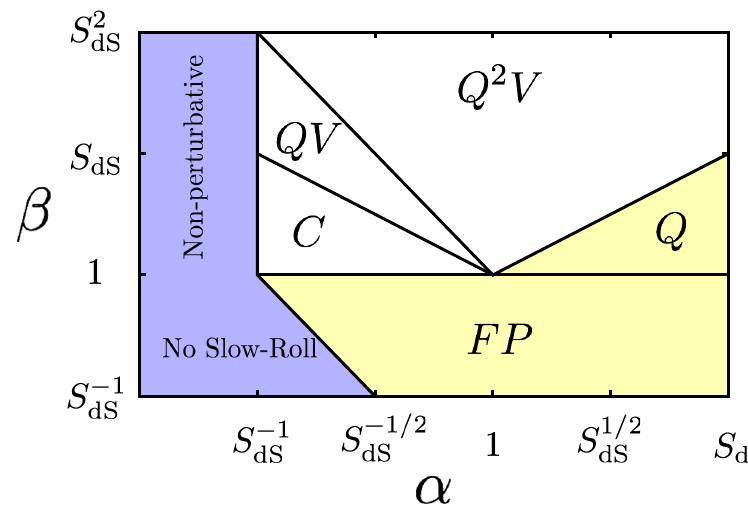
Figure 1 . The different regimes of the FPV dynamics for an EFT potential parametrised by α and β . For α (cid:28) 1 /S the field range is non-perturbative and for α 2 β (cid:28) ξ/S 2 dS longer in slow-roll regime (shown for ξ = 1 ). The Q and FP regimes are relatively uninteresting for SOL because the volume term is only a subleading